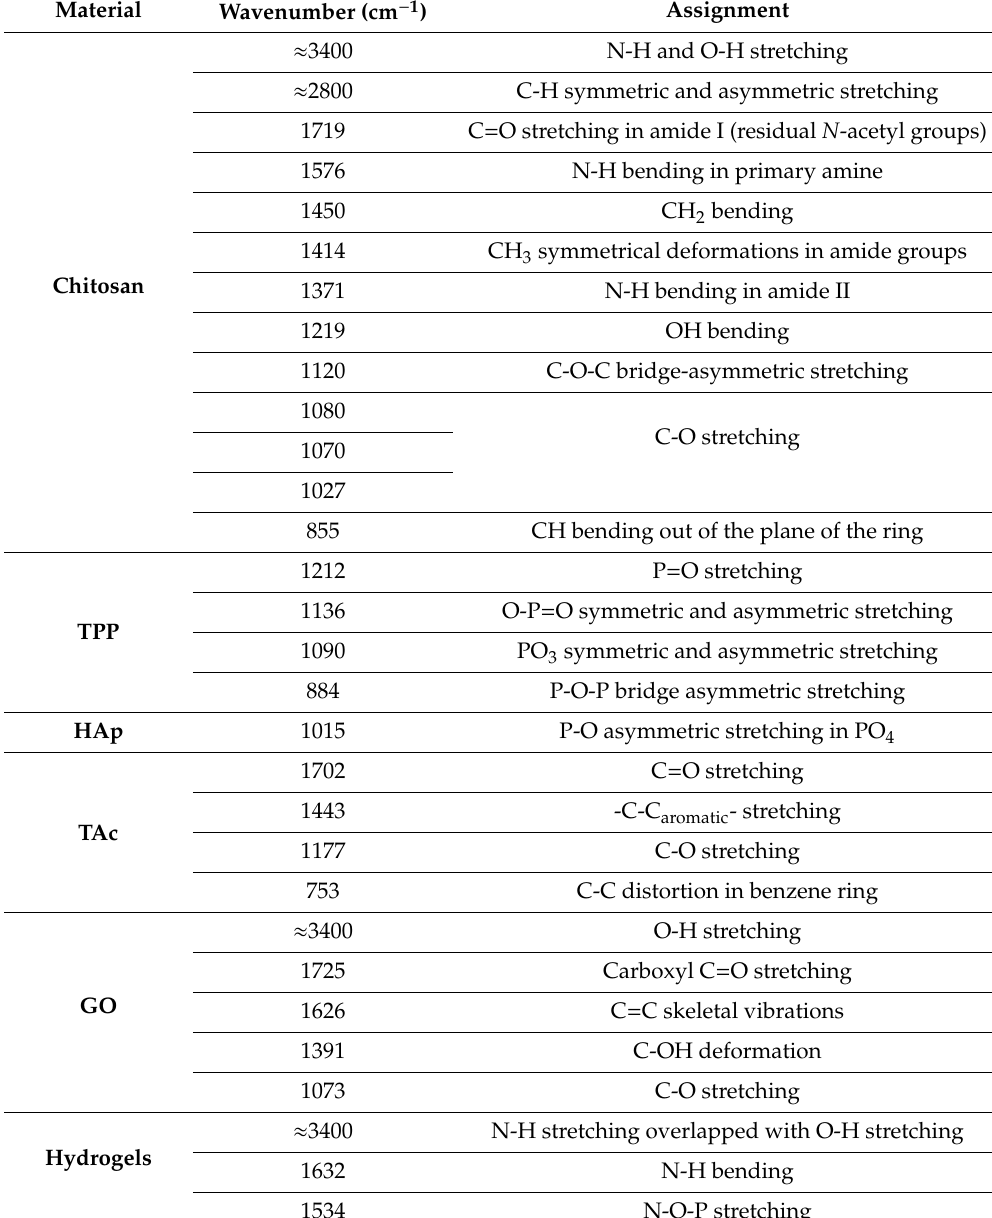
Table 1. The main characteristic peaks of the hydrogel components (TPP—sodium tripolyphosphate, HAp—hydroxyapatite, TAc—tannic acid, GO—graphene